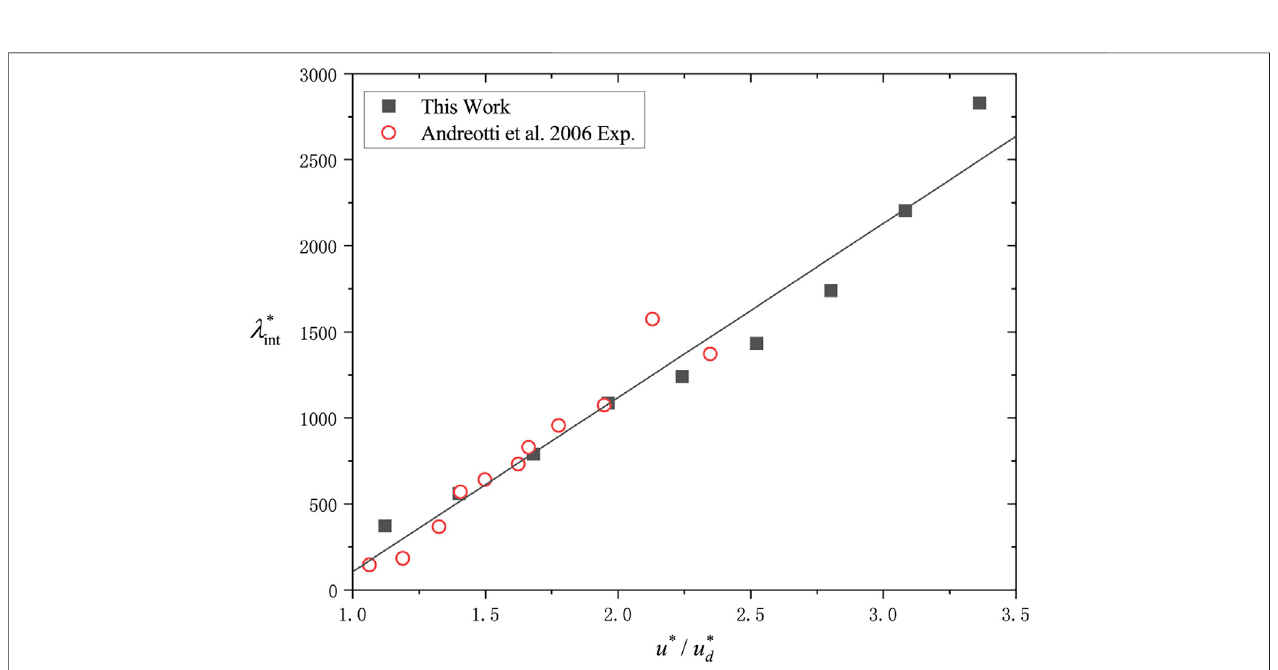
FIGURE 7 | Initial wavelength λ int grows as a function of u * / u * d (solid symbols), compared with results from the wind tunnel experiment (hollow symbols). The solid line is the linear fi tting of the simulation result.